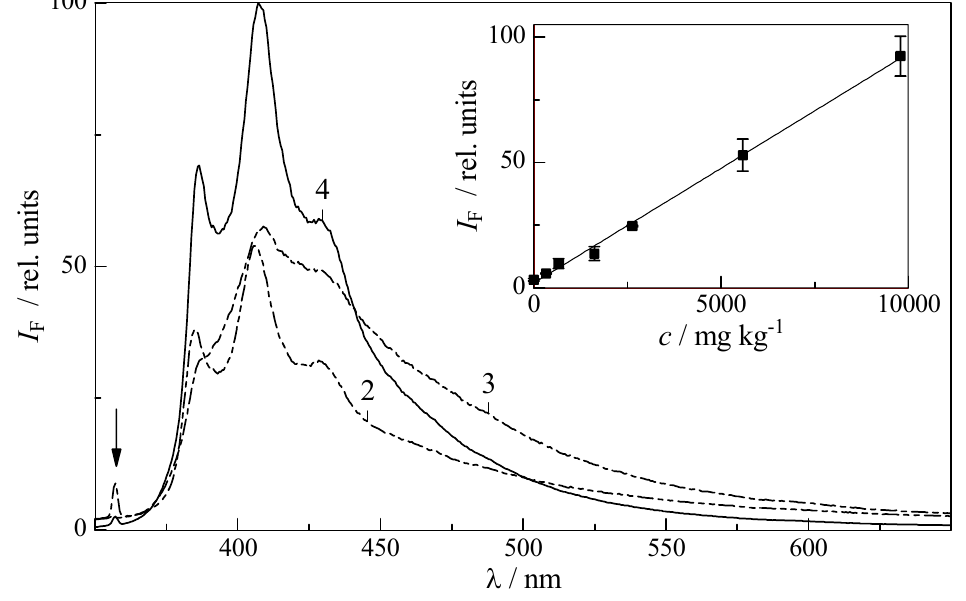
=355 nm). The arrow marks a spectral exc =266 exc